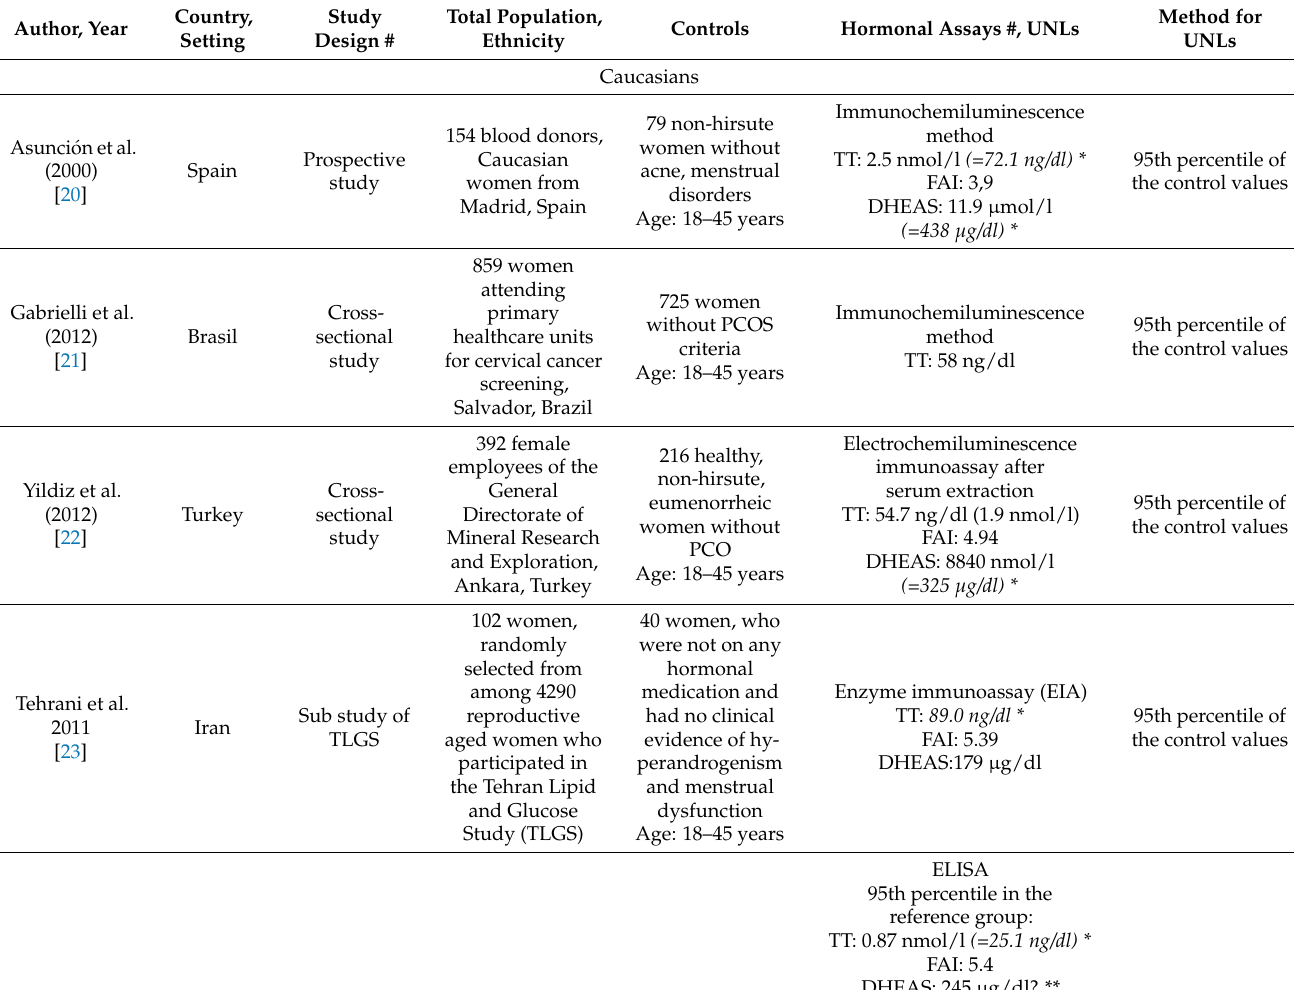
Table 6. Population-based epidemiological studies with the developed UNLs for TT, DHEAS, and FAI in premenopausal Caucasian and Asian